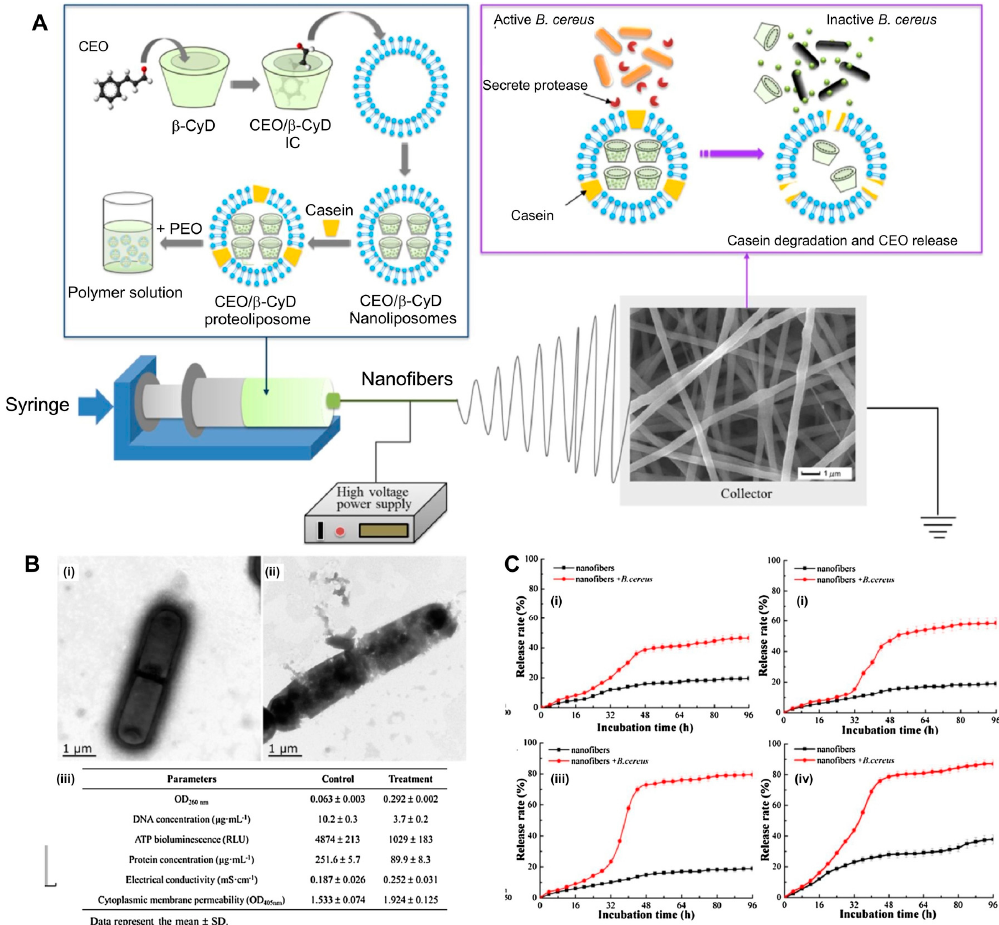
Figure 4. ( A ) Cartoon schemes of the production of CEO/ β -CyD proteoliposomes incorporated poly(ethylene oxide) (PEO) fibers and B. cereus proteinase triggered cinnamon essential oil (CEO) delivery from CEO/ β -CyD proteoliposomes. ( B ) TEM images of B. cereus before ( i ) and after the treatment ( ii ) of CEO/ β -CyD proteoliposomes. ( iii ) The respective analysis results on the release of B. cereus cell constituents and the cell membrane permeability before and after proteoliposomes treatment. ( C ) The release rate of CEO/ β -CyD proteoliposomes nanofibers stored at different temperatures 4 ◦ C ( i ), 12 ◦ C ( ii ), 25 ◦ C ( iii ), and 37 ◦ C ( iv ) for 4 days. The figure was